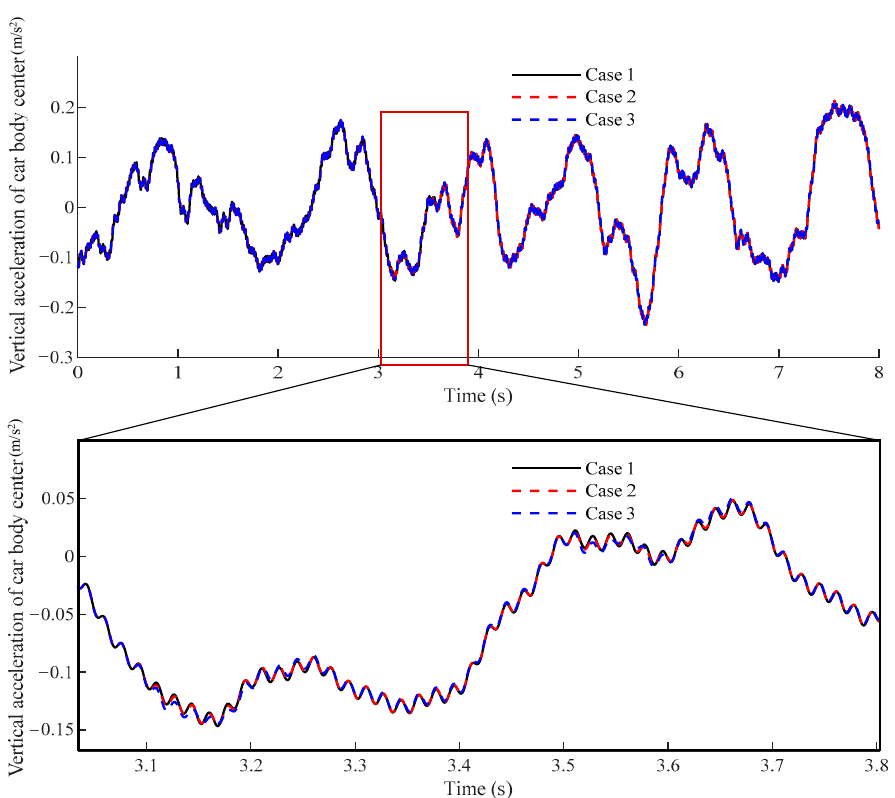
Figure 7. Time–history curve of car body vertical acceleration.